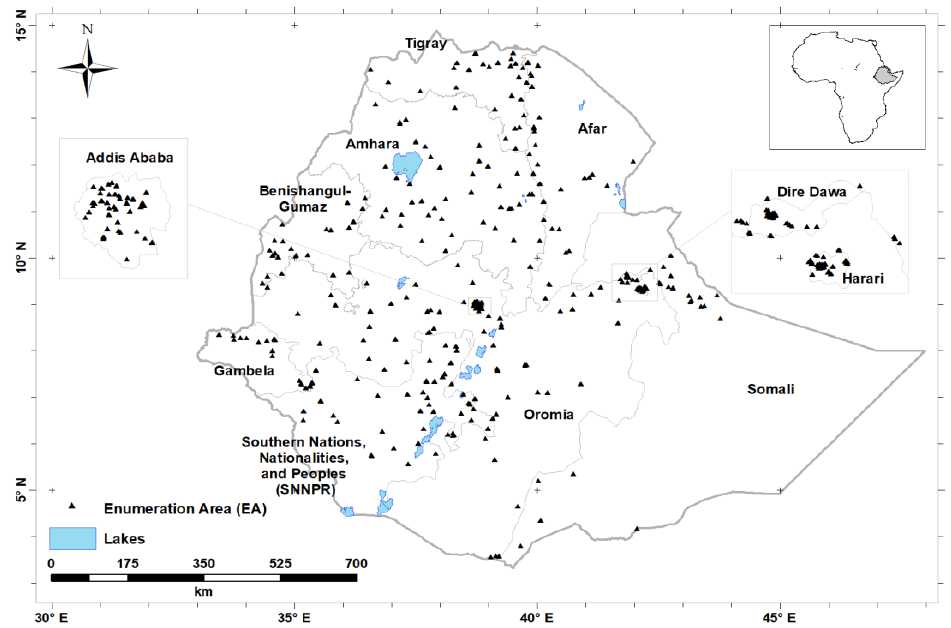
Figure 1. Locations of Enumeration Areas ( n = 346), from which study participants were recruited.